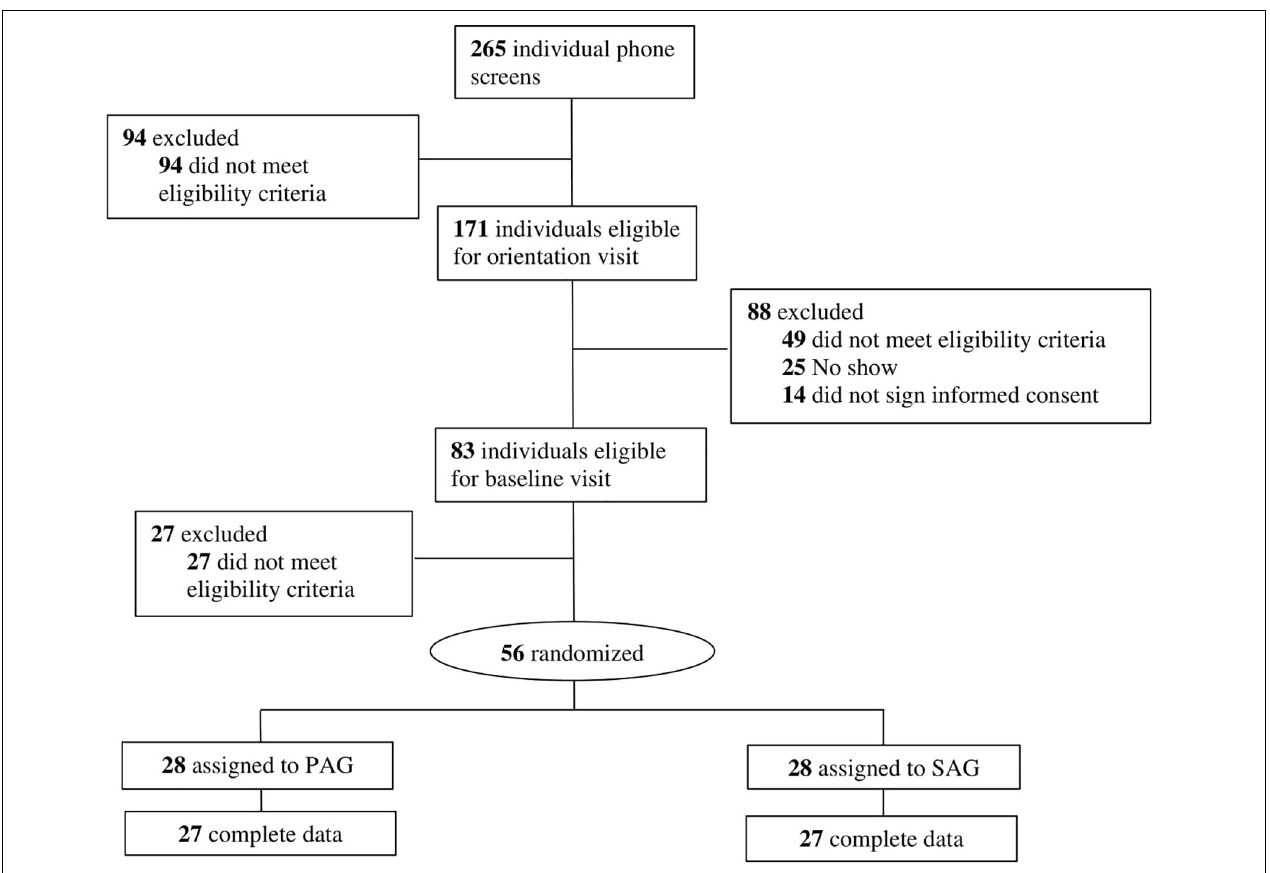
FIGURE 1 | Consort flow